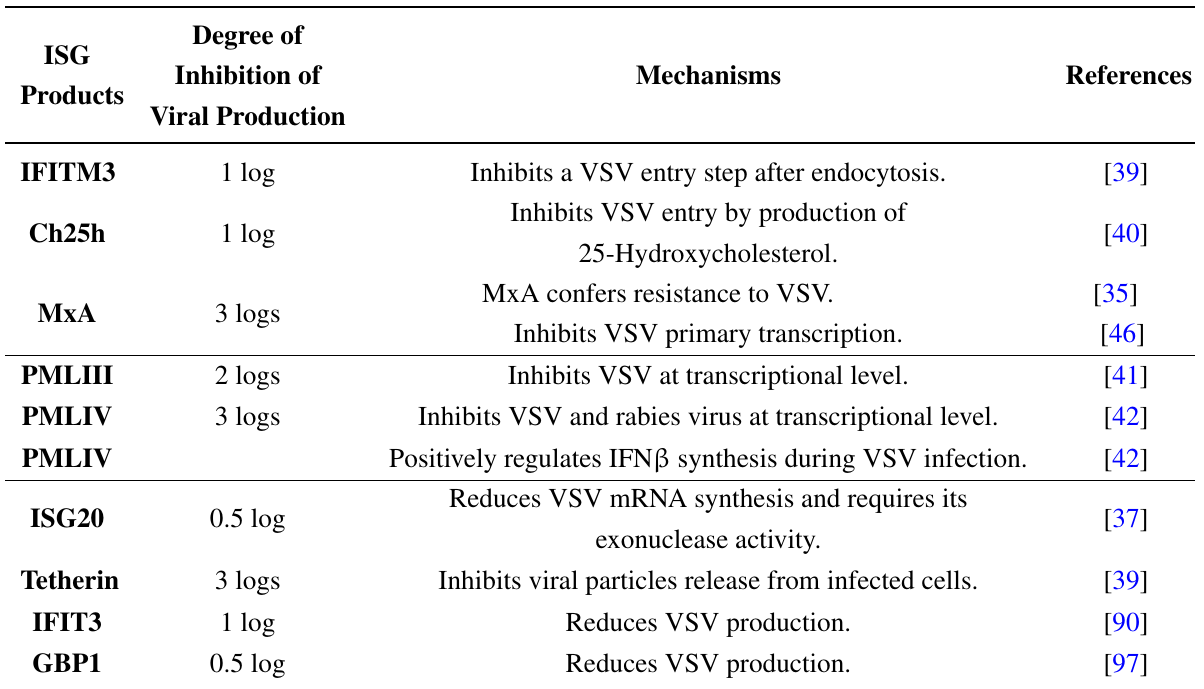
Table 1. Main human ISG products conferring intrinsic resistance to vesicular stomatitis virus (VSV) and rabies